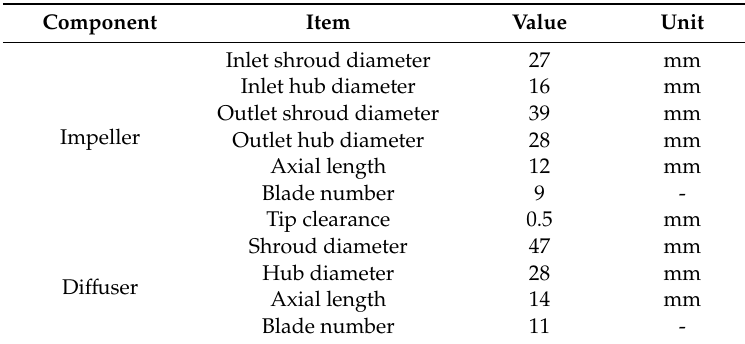
Table 1. Main parameters of the